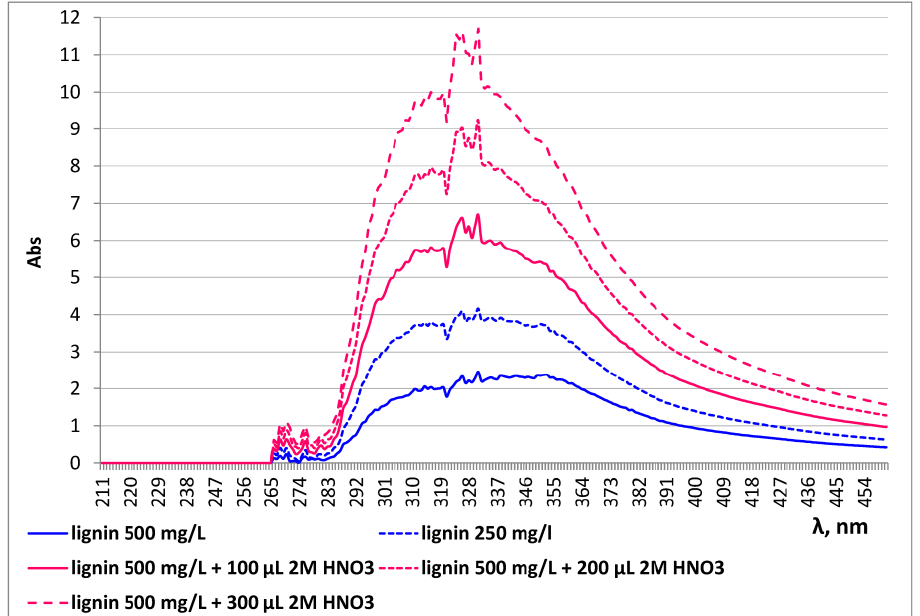
Figure 4. UV/Vis spectrophotometric spectra of aqueous alkali lignin solutions and HNO 3 -treated lignin solutions.